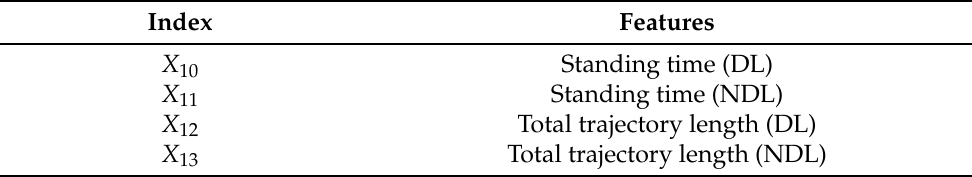
Table 4. Inputs to the neural network considered for the one-leg standing